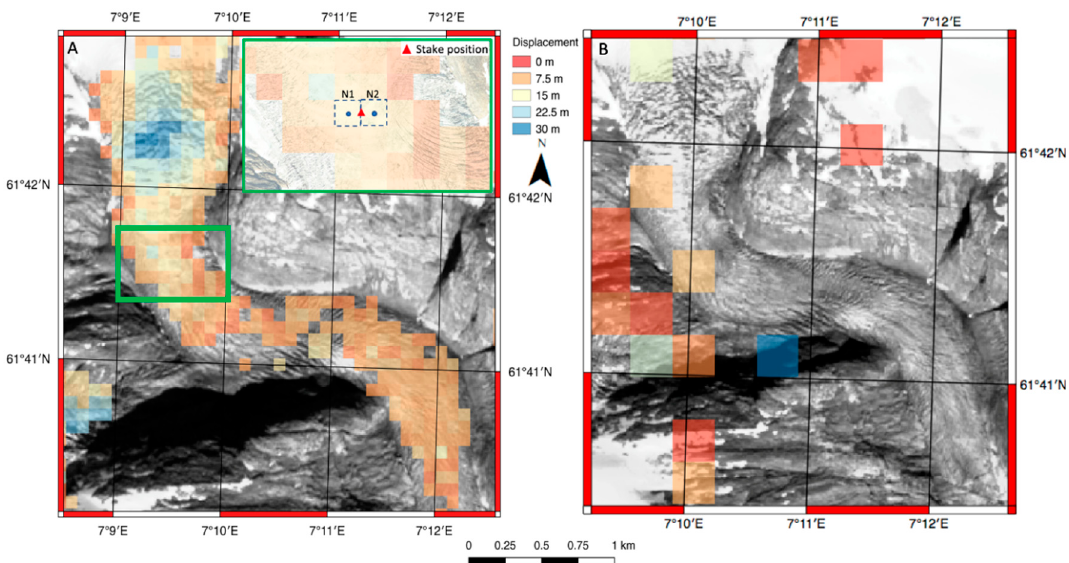
Figure 7. ( a ) SenDiT derived displacement map of pair 27.08.2017–16.09.2017 over Nigardsbreen outlet glacier with a close-up image of a position of the stake and points N1 and N2 over orthophoto from 26.08.2017 with 0,25 m ground resolution; ( b ) GoLIVE service displacement map of pair